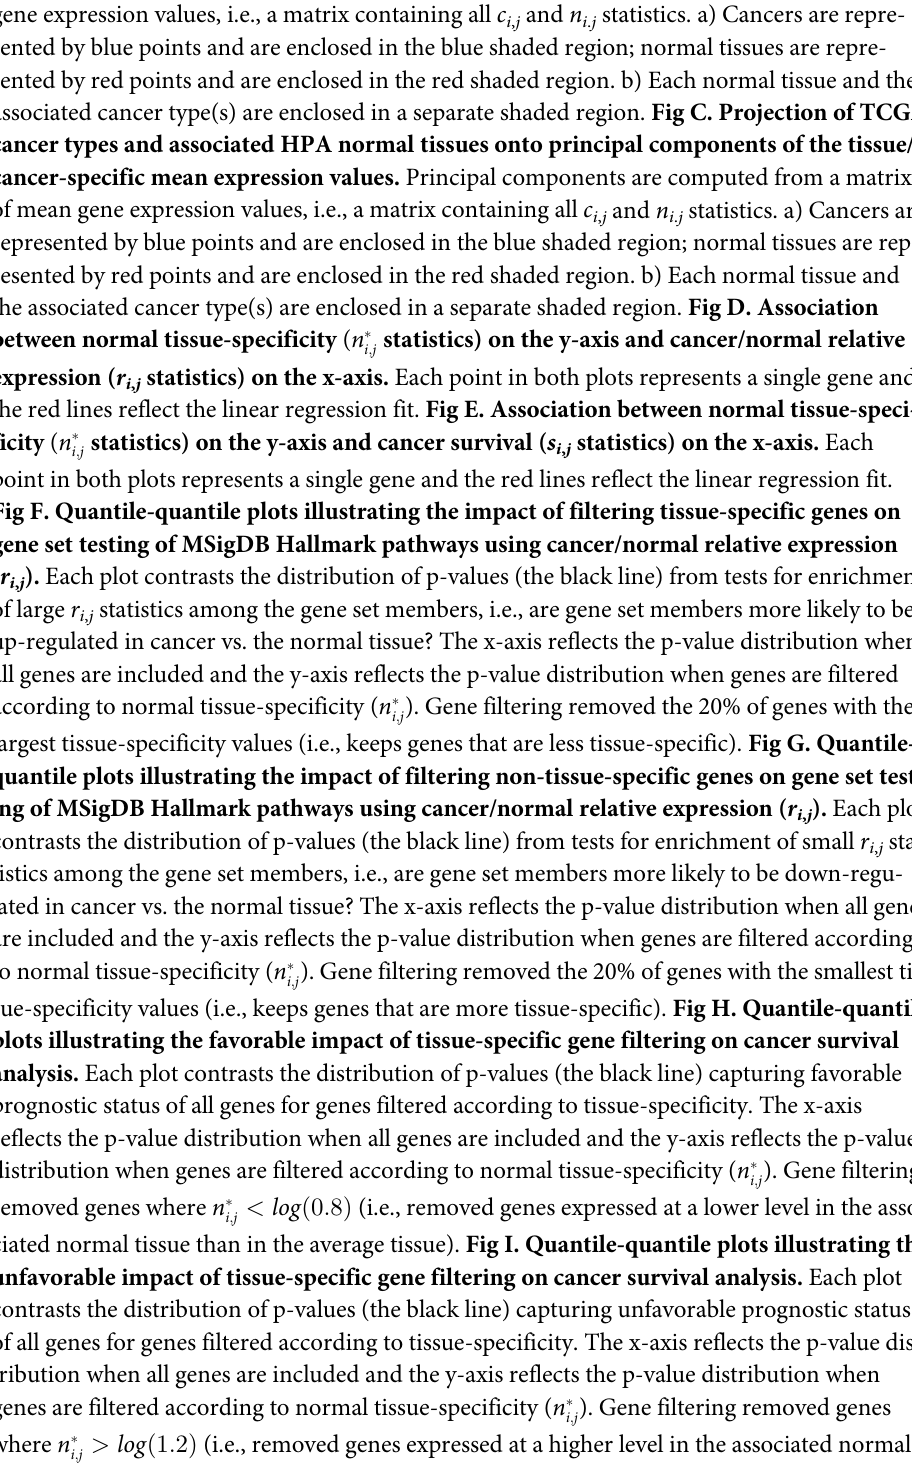
distance’. Fig A. Variance of the PCs of the mean gene expression matrix. Fig B. Projection of TCGA cancer types and associated HPA normal tissues onto principal components 3–8 of the mean expression values. Principal components are computed from a matrix of mean gene expression values, i.e., a matrix containing all c and n statistics. a) Cancers are repre- i , j i . j sented by blue points and are enclosed in the blue shaded region; normal tissues are repre- sented by red points and are enclosed in the red shaded region. b) Each normal tissue and the associated cancer type(s) are enclosed in a separate shaded region. Fig C. Projection of TCGA cancer types and associated HPA normal tissues onto principal components of the tissue/ cancer-specific mean expression values. Principal components are computed from a matrix of mean gene expression values, i.e., a matrix containing all c and n statistics. a) Cancers are i , j i . j represented by blue points and are enclosed in the blue shaded region; normal tissues are rep- resented by red points and are enclosed in the red shaded region. b) Each normal tissue and the associated cancer type(s) are enclosed in a separate shaded region. Fig D. Association between normal tissue-specificity ( n � statistics) on the y-axis and cancer/normal relative i ; j expression ( r statistics) on the x-axis. Each point in both plots represents a single gene and i , j the red lines reflect the linear regression fit. Fig E. Association between normal tissue-speci- ficity ( n � statistics) on the y-axis and cancer survival ( s statistics) on the x-axis. Each i , j i ; j point in both plots represents a single gene and the red lines reflect the linear regression fit. Fig F. Quantile-quantile plots illustrating the impact of filtering tissue-specific genes on gene set testing of MSigDB Hallmark pathways using cancer/normal relative expression ( r ). Each plot contrasts the distribution of p-values (the black line) from tests for enrichment i , j of large r statistics among the gene set members, i.e., are gene set members more likely to be i , j up-regulated in cancer vs. the normal tissue? The x-axis reflects the p-value distribution when all genes are included and the y-axis reflects the p-value distribution when genes are filtered according to normal tissue-specificity ( n � ). Gene filtering removed the 20% of genes with the i ; j largest tissue-specificity values (i.e., keeps genes that are less tissue-specific). Fig G. Quantile- quantile plots illustrating the impact of filtering non-tissue-specific genes on gene set test- ing of MSigDB Hallmark pathways using cancer/normal relative expression ( r ). Each plot i , j contrasts the distribution of p-values (the black line) from tests for enrichment of small r sta- i , j tistics among the gene set members, i.e., are gene set members more likely to be down-regu- lated in cancer vs. the normal tissue? The x-axis reflects the p-value distribution when all genes are included and the y-axis reflects the p-value distribution when genes are filtered according to normal tissue-specificity ( n � ). Gene filtering removed the 20% of genes with the smallest tis- i ; j sue-specificity values (i.e., keeps genes that are more tissue-specific). Fig H. Quantile-quantile plots illustrating the favorable impact of tissue-specific gene filtering on cancer survival analysis. Each plot contrasts the distribution of p-values (the black line) capturing favorable prognostic status of all genes for genes filtered according to tissue-specificity. The x-axis reflects the p-value distribution when all genes are included and the y-axis reflects the p-value distribution when genes are filtered according to normal tissue-specificity ( n � ). Gene filtering i ; j removed genes where n � < log ð 0 : 8 Þ (i.e., removed genes expressed at a lower level in the asso- i ; j ciated normal tissue than in the average tissue). Fig I. Quantile-quantile plots illustrating the unfavorable impact of tissue-specific gene filtering on cancer survival analysis. Each plot contrasts the distribution of p-values (the black line) capturing unfavorable prognostic status of all genes for genes filtered according to tissue-specificity. The x-axis reflects the p-value dis- tribution when all genes are included and the y-axis reflects the p-value distribution when genes are filtered according to normal tissue-specificity ( n � ). Gene filtering removed genes i ; j where n � > log ð 1 : 2 Þ (i.e., removed genes expressed at a higher level in the associated i ; j